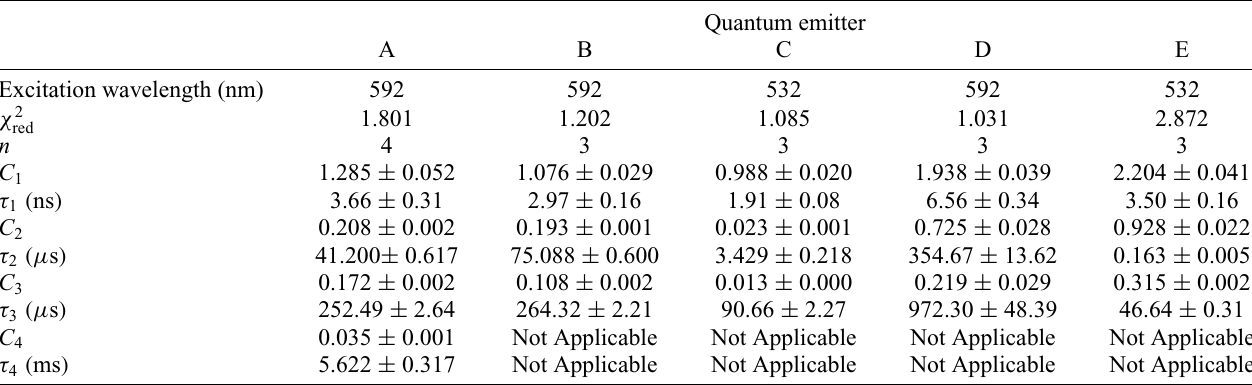
TABLE IV. Long-timescale autocorrelation function fit parameters.